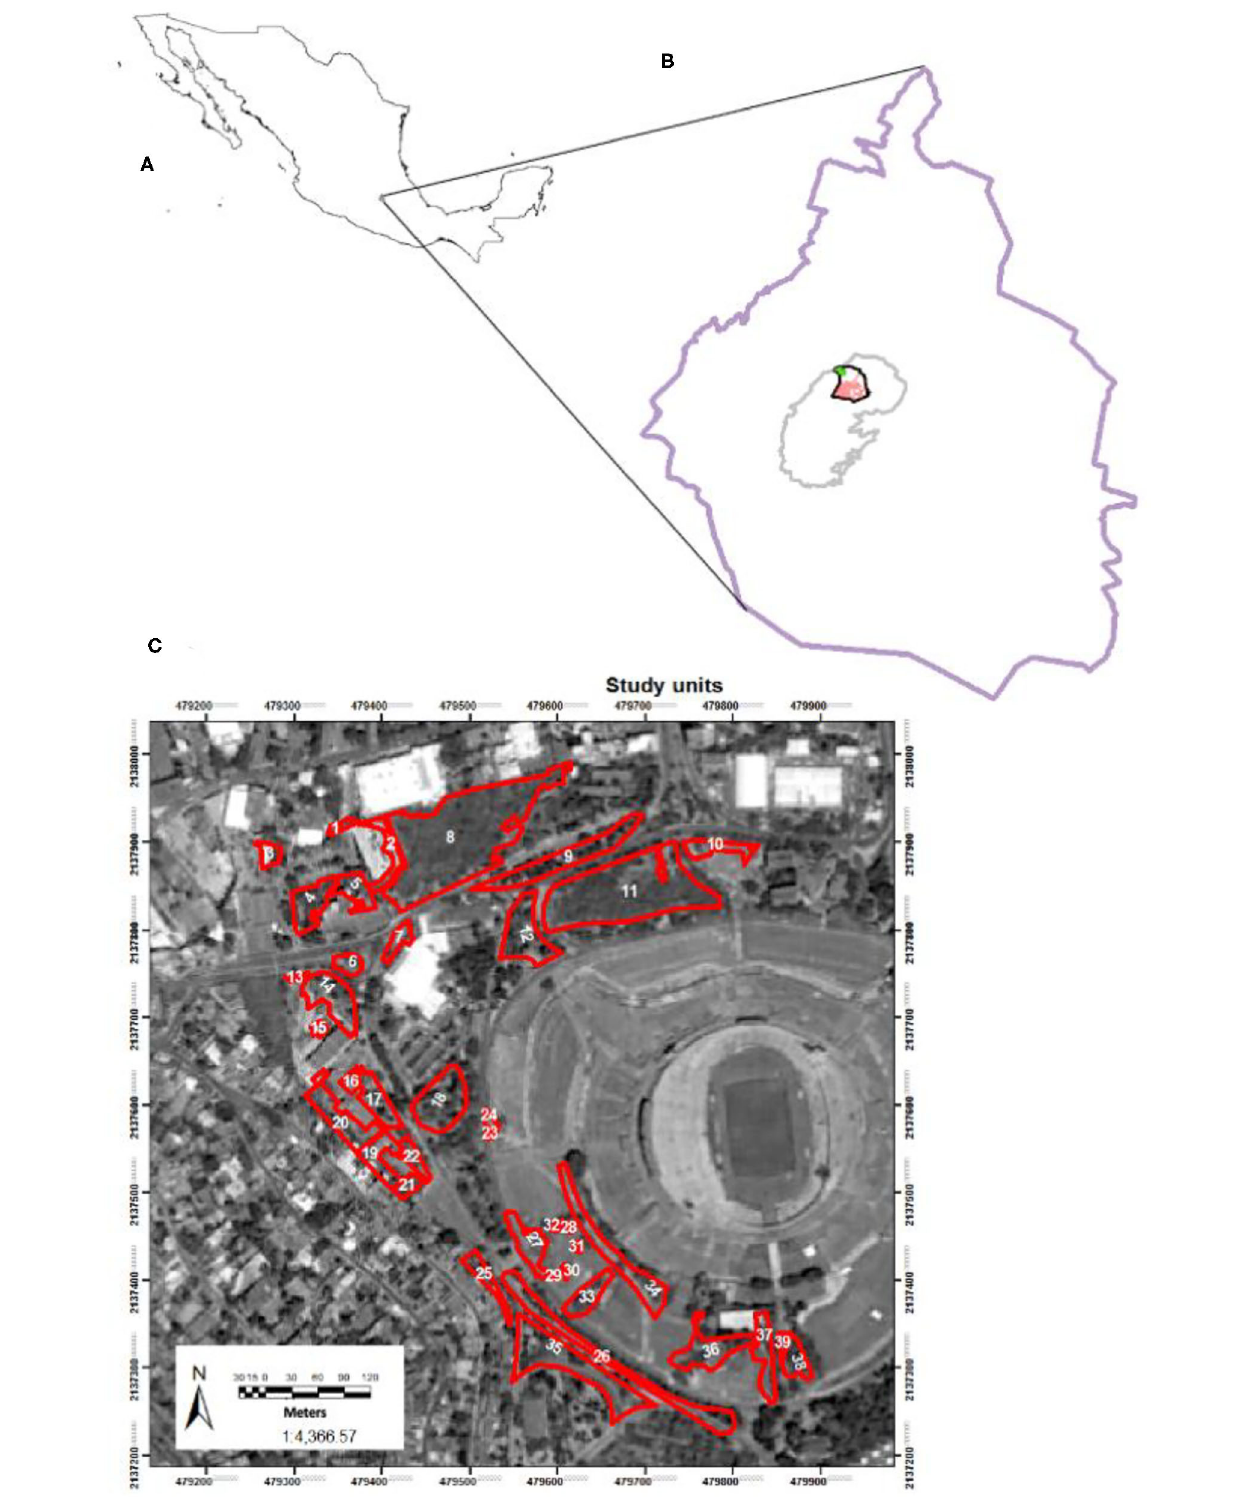
FIGURE 1 | Study area and location of study sites. Location of Mexico City in Mexico (A) ; location of the lava field of San Ángel (grey polygon), University campus (black polygon), the Ecological Reserve of the Pedregal of San Ángel (red polygon) and the study area (green polygon) within Mexico City (purple polygon) (B) ; location of the 39 study sites (in red) around the University Olympic Stadium. This map was elaborated from a GIS archive of lava field remnants at the main campus provided in 2017 by the Department of Cartography and Geographic Information Systems of the Executive Secretary of the Ecological Reserve of the Pedregal of San Angel.